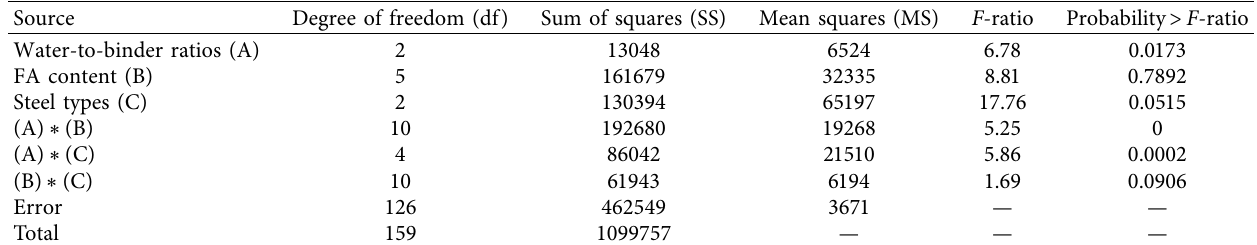
Table 5: ANOVA result for rest potential for uncarbonated concrete.